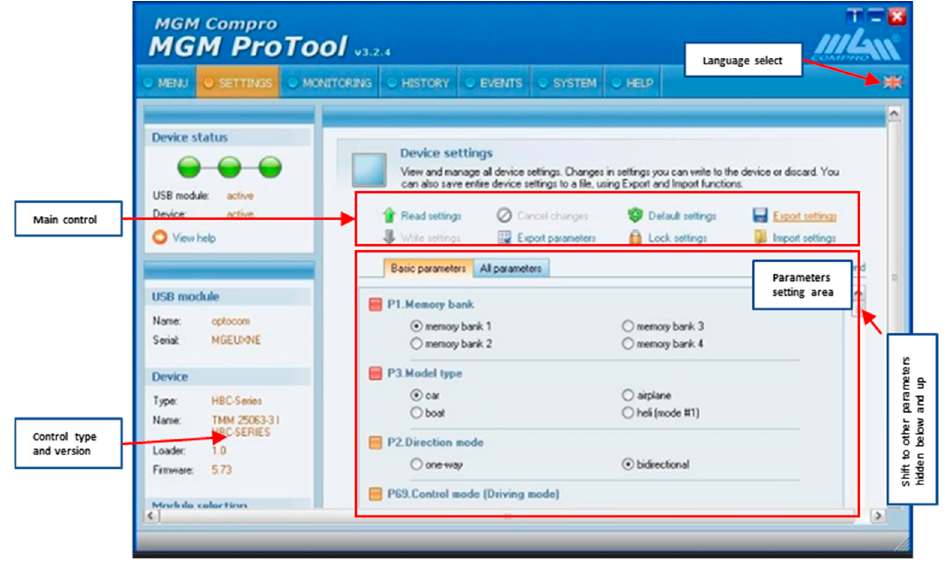
Figure 6. Controller 2 software screen with description and the possible values for all the parameters.